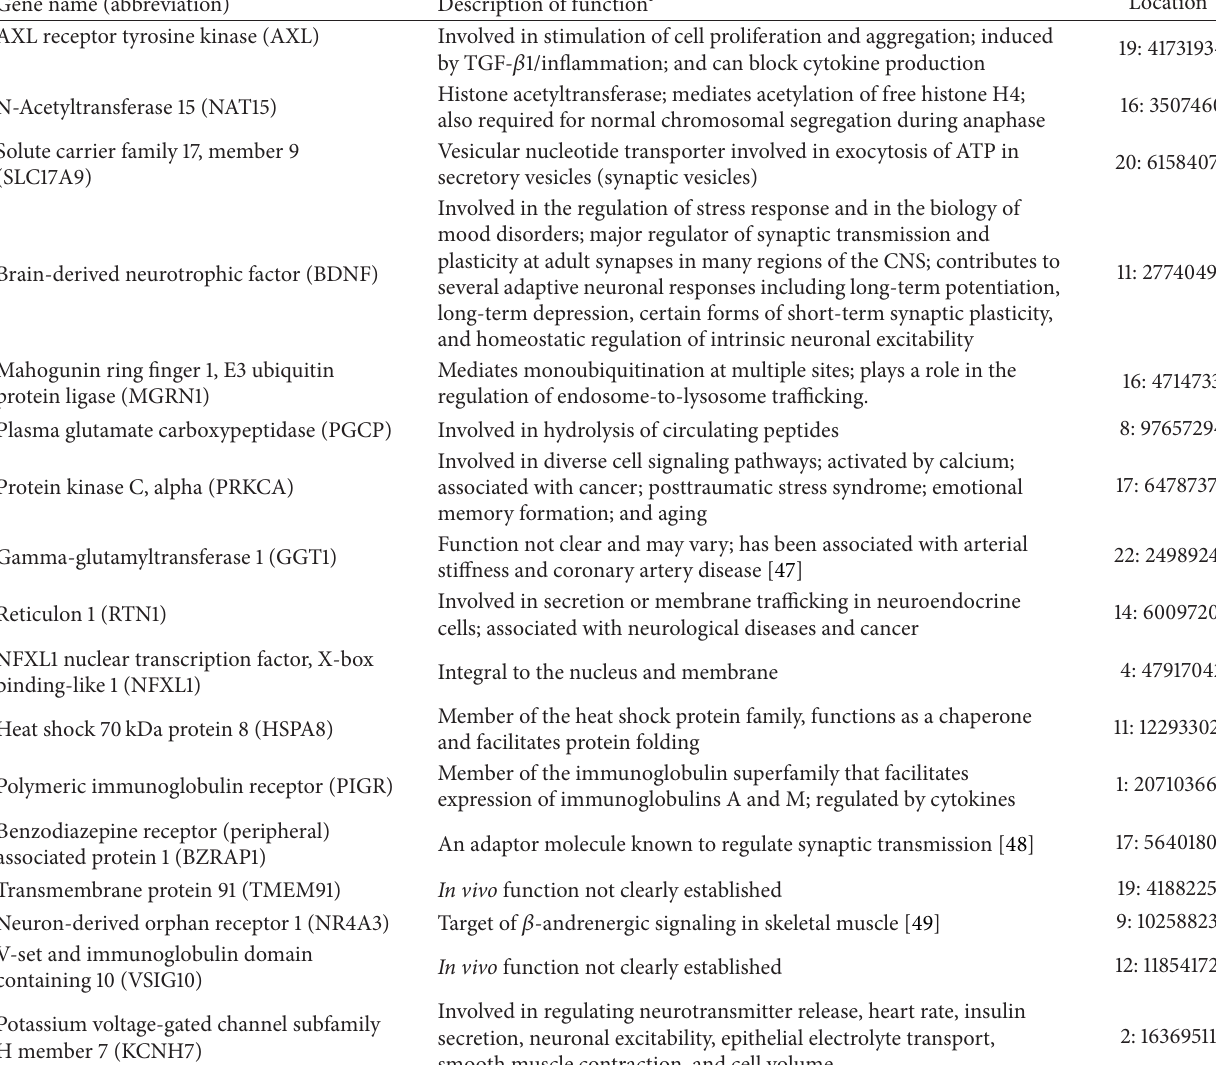
Table 2: Genes associated with sites differentially methylated in patients with